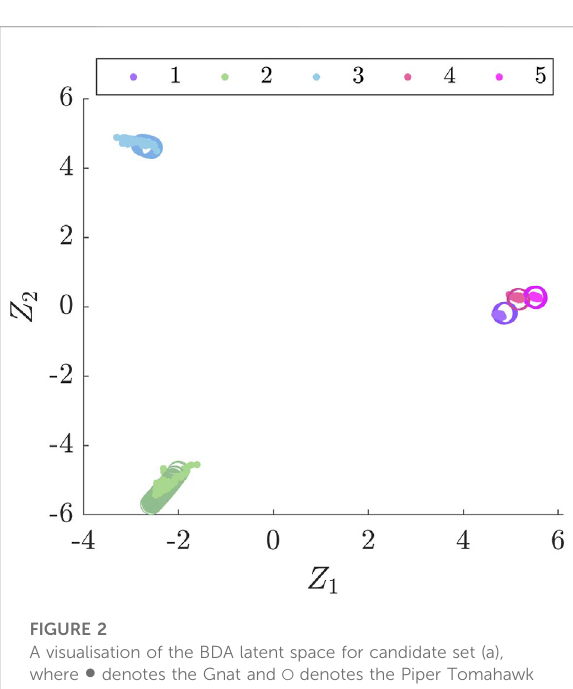
FIGURE 2 A visualisation of the BDA latent space for candidate set (a), (cid:129) where denotes the Gnat and ○ denotes the Piper Tomahawk